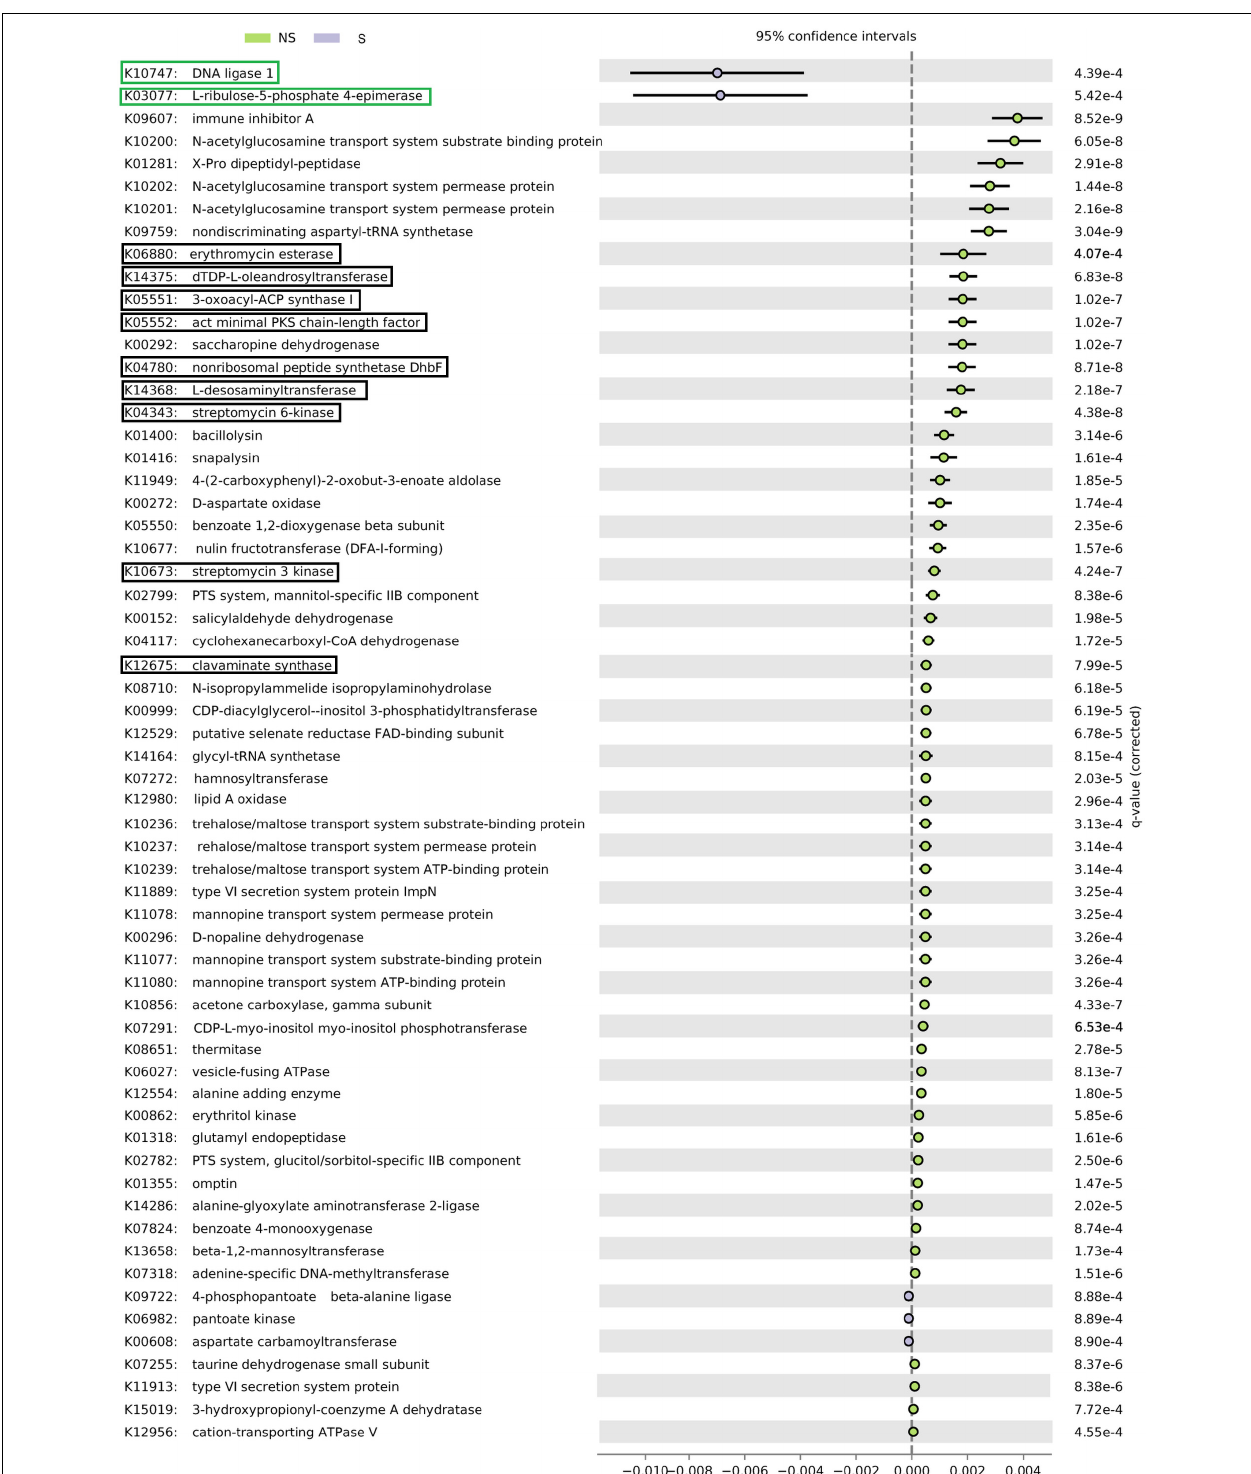
FIGURE 6 | PICRUSt analysis of bacterial sequences. Barplots for most significantly different KO categories. Error bars represent standard error of the mean of given category abundance in different sample types. Categories belonging to DNA replication and repair supercategory and are shown in green boxes, while antibiotic synthesis and resistance is displayed in black boxes. Q -values (False Discovery Rates, based on two-sided Welche’s test with Benjamini-Hochberg correction) are given to the right of each category plot.